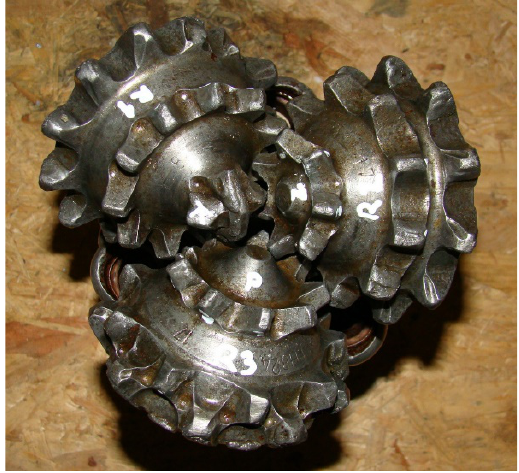
Figure 7. Drill bit condition after the drilled interval of 87.89 m.